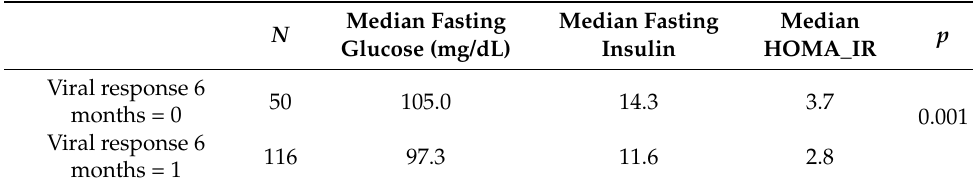
Table 5. Characterization of the lot in terms of carbohydrate metabolism. HOMA-IR: homeostasis model of insulin